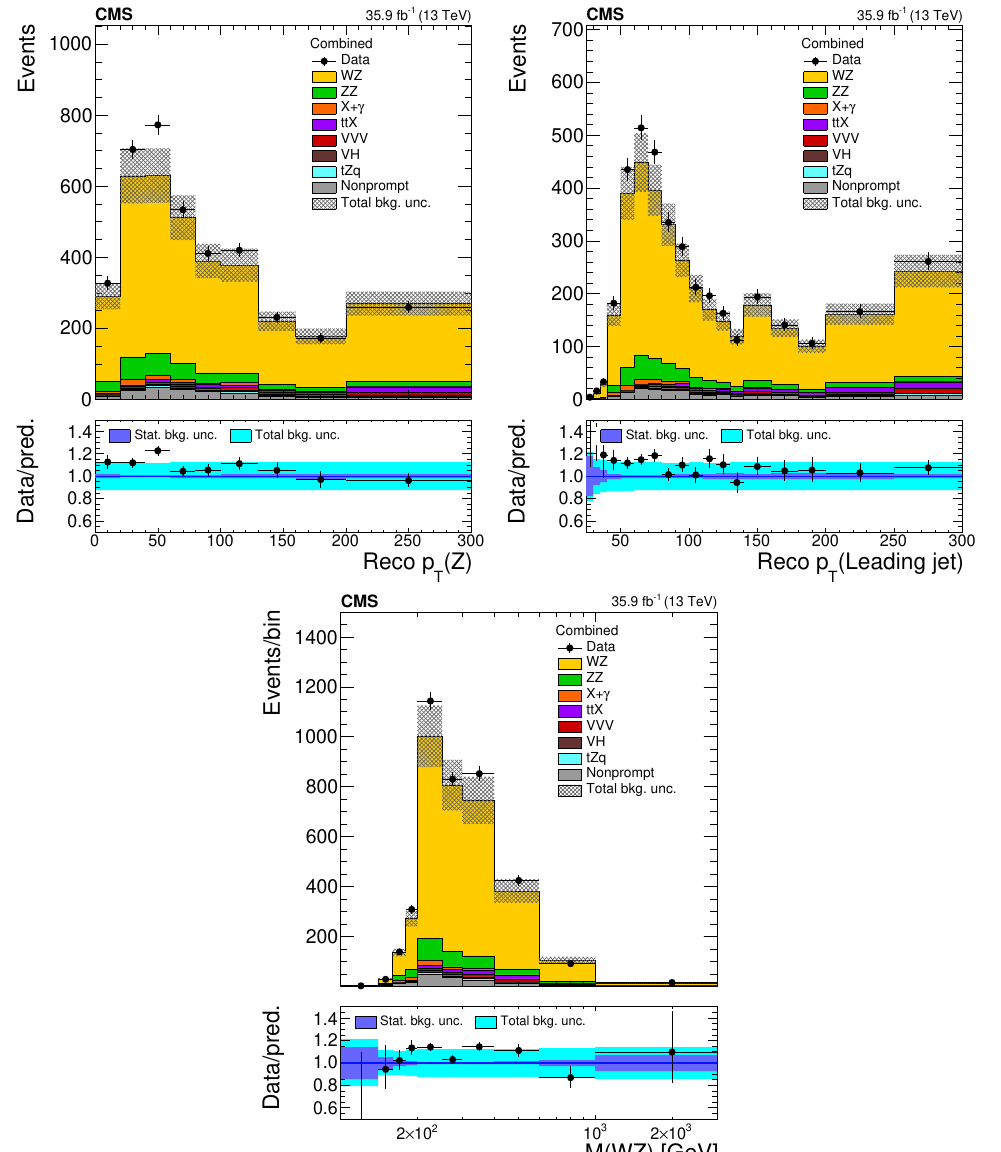
Figure 8 . Pre(cid:12)t distributions of key observables in the signal region. The transverse momentum of the Z boson (top left), the transverse momentum of the leading jet (top right), and the mass of the WZ system (bottom). The last bin contains the over(cid:13)ow. Vertical bars on the data points include the statistical uncertainty and the shaded band over the MC prediction include both the statistical and the systematic uncertainties in the normalization of each of the background processes. An additional 15% uncertainty is assigned to the signal WZ process in the (cid:12)gures to account for the NLO/NNLO normalization di(cid:11)erences.